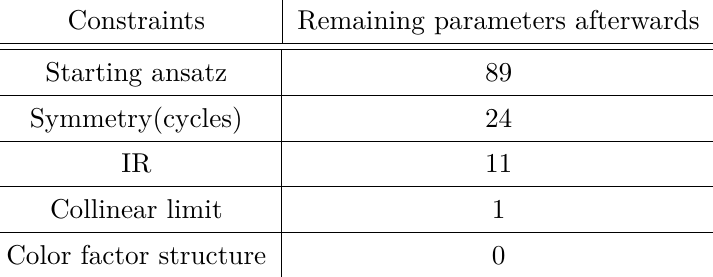
Table 1. Solving ansatz via various constraints for two-loop three-point tr( φ 2 )